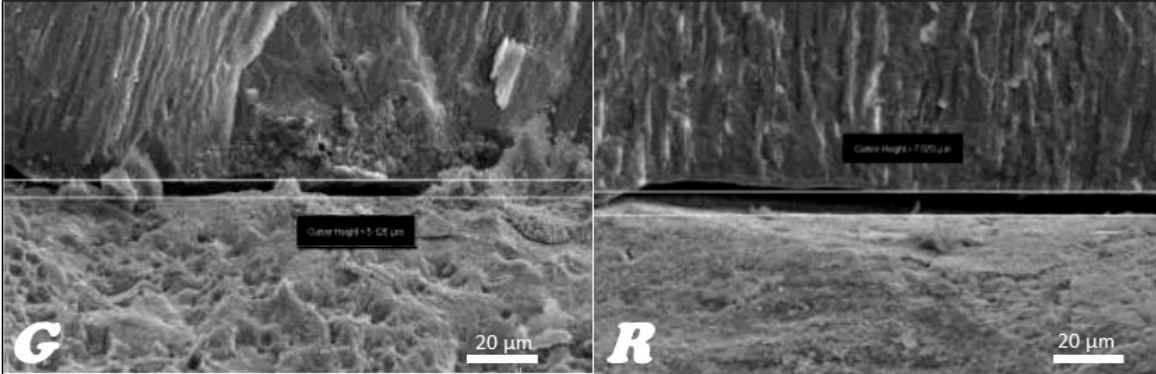
Figure 29. Examples of leakage on the border of the sealant and dentin of the root canal hot ‐ filled with the thermoplastic technique THC ( G ) with a width of 5.126 μ m in the case of using a material based on gutta ‐ percha and ( R ) with a width of 7.070 μ m with the use of resilon; SEM.